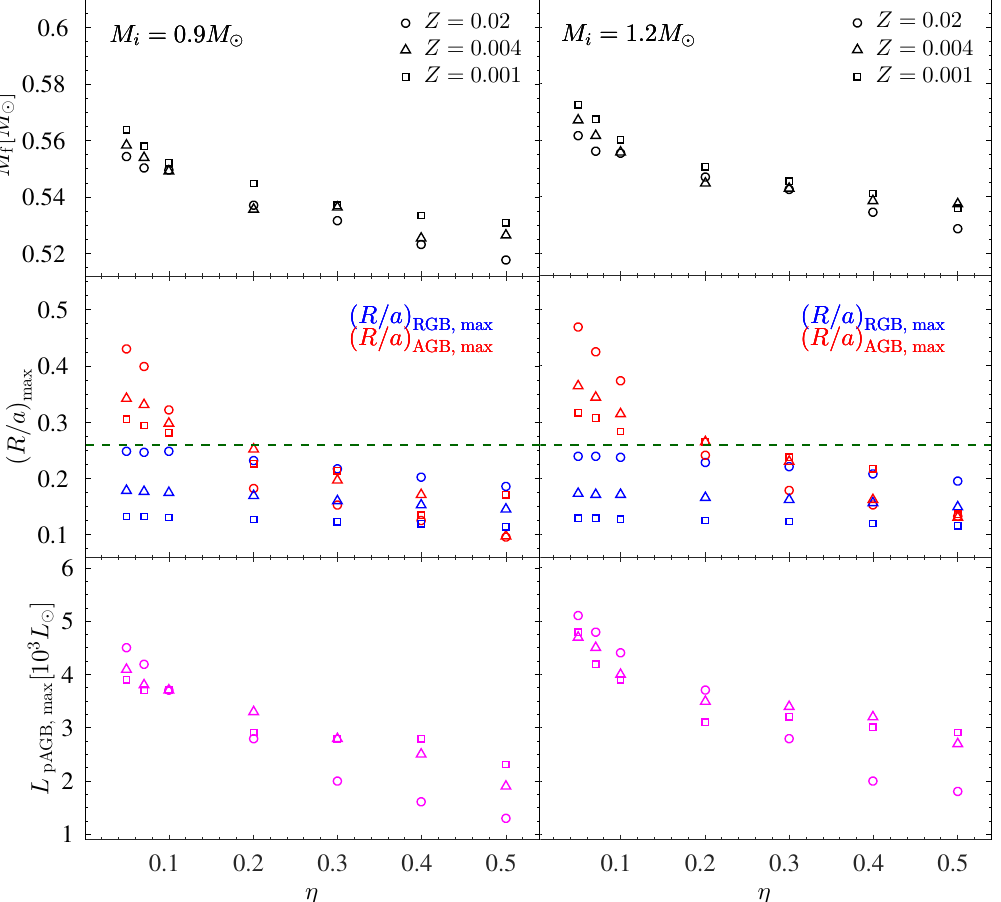
Figure 2. The summary of the evolution of a 0.9 M (cid:12) star ( left plot ) and a 1.2 M (cid:12) star ( right plot ). For each star we studied the evolution from zero age main sequence until the formation of a white dwarf, for several mass-loss rate efficiency parameters, from η = 0.5 (the “traditional” commonly mass-loss rate) to as low as η = 0.05. We present the evolution for 3 metallicities: Z = 0.02 (circles), Z = 0.004 (triangles) and Z = 0.001 (squares). The upper panels present the final white dwarf mass of each star. The middle panels present the maximum value of the stellar radius over the orbital separation, ( R / a ) , for both the red giant branch (RGB; blue) and the asymptotic giant branch (AGB; red). max The companion mass is 10 M J and the initial orbital separation taken is 3 AU . The green horizontal line indicates the capture condition above which planet engulfment can take place (Equation (2)). The lower panels present the maximum value of the luminosity on the post-AGB, L pAGB, max